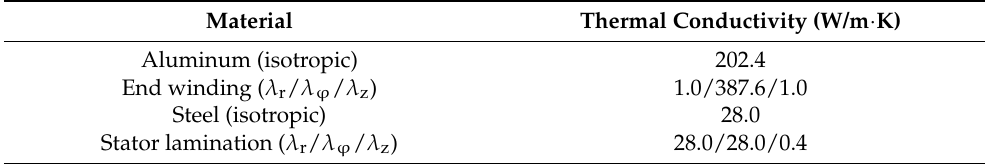
Table 5. The material properties of the modelled